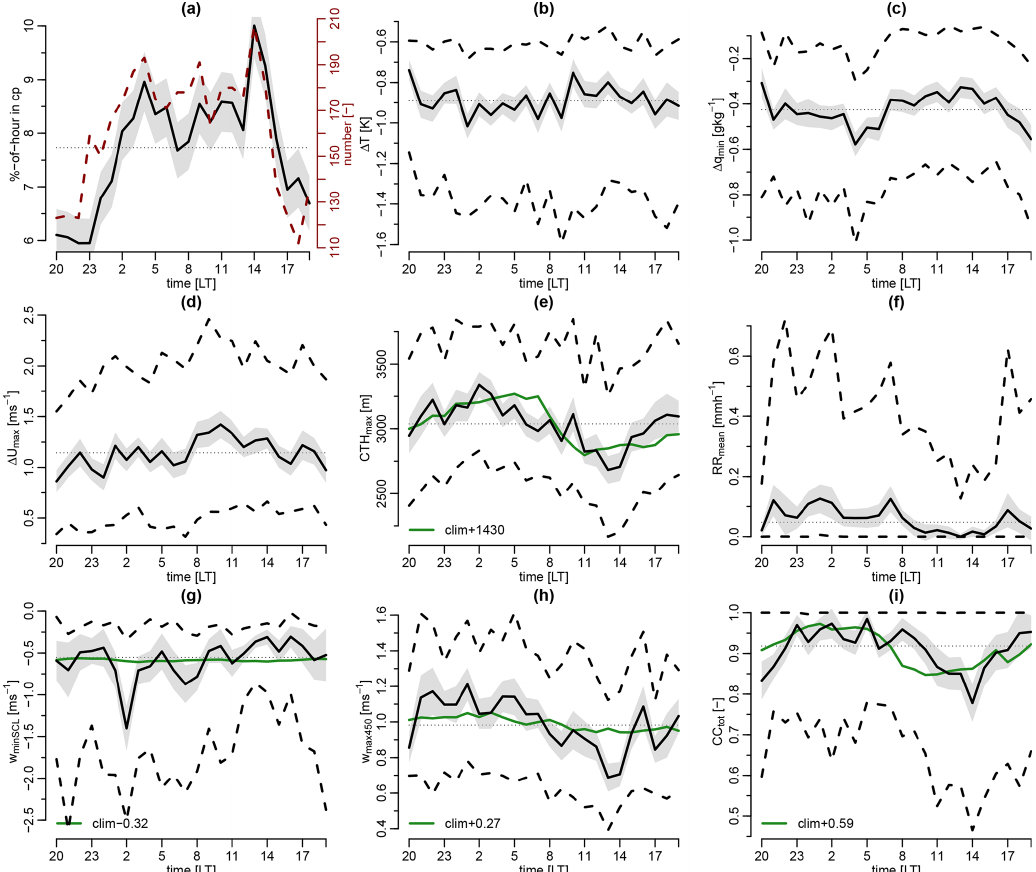
Figure 6. Daily cycles of important cold-pool diagnostics. (a) Mean ± 1SE of hourly cold-pool frequency as well as the number of cold pools per hour, (b) (cid:49)T , (c) (cid:49)q min , (d) (cid:49)U max , (e) CTH max , (f) MRR RR mean , (g) w minSCL , (h) w max450 , and (i) CC tot , with cold pools associated with a specific hour according to their t max . In panels (b) – (i) the lines represent the 25%, 50%, and 75% quartiles of the respective variables and the shading represents the median ± 1SE. Also indicated in green is the median climatological background diel cycle of 30min values of (e) maximum CTH, (g) minimum w SCL , (h) maximum w 450 , and (i) mean CC, shifted by the mean difference of the climatological median compared to the cold-pool median to ease reading. Due to the infrequent rain, the median climatological RR mean is always 0 and omitted in panel (f)